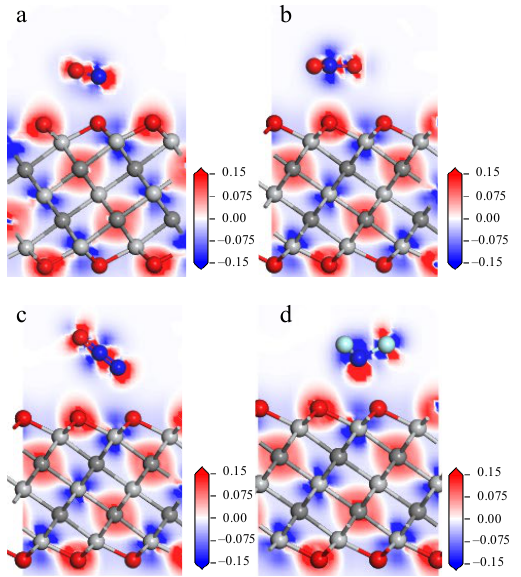
Figure 5. Deformation charge density diagram of ( a ) NO, ( b ) NO 2 , ( c ) N 2 O, ( d ) NF 3 on Ti 3 C 2 O 2 surface.